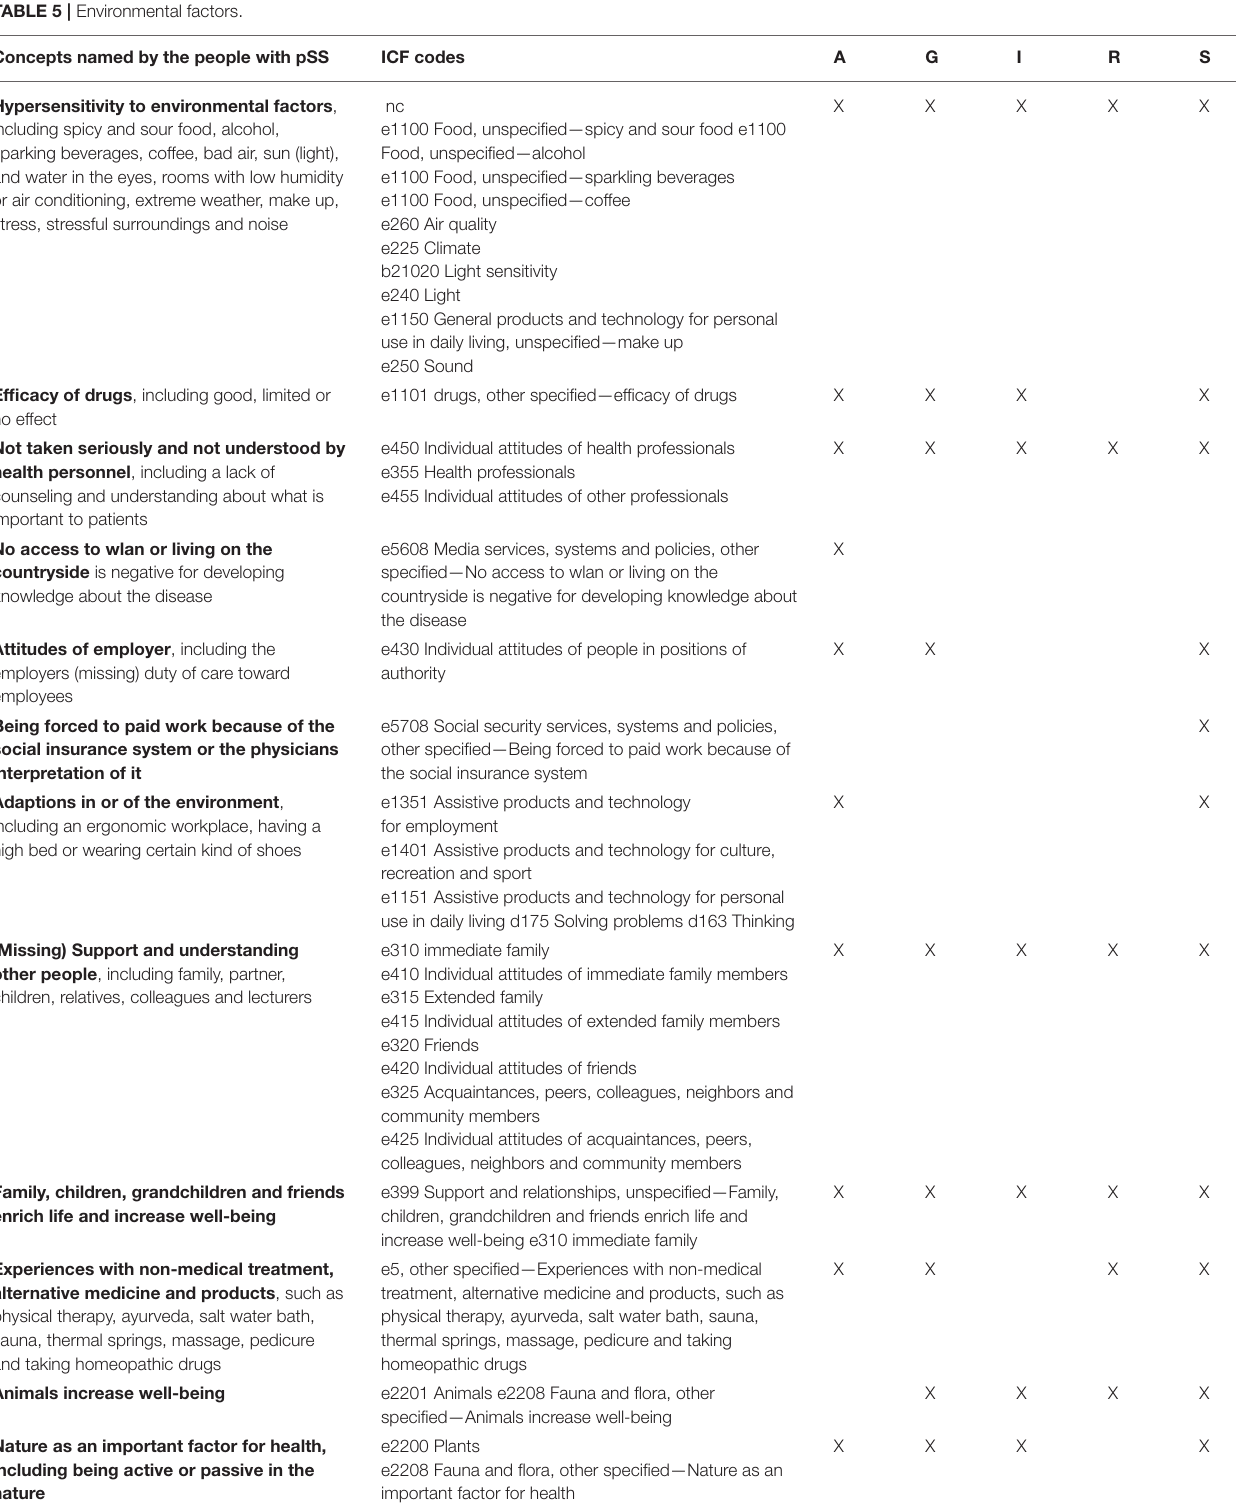
TABLE 5 | Environmental factors. Concepts named by the people with pSS ICF codes A G I